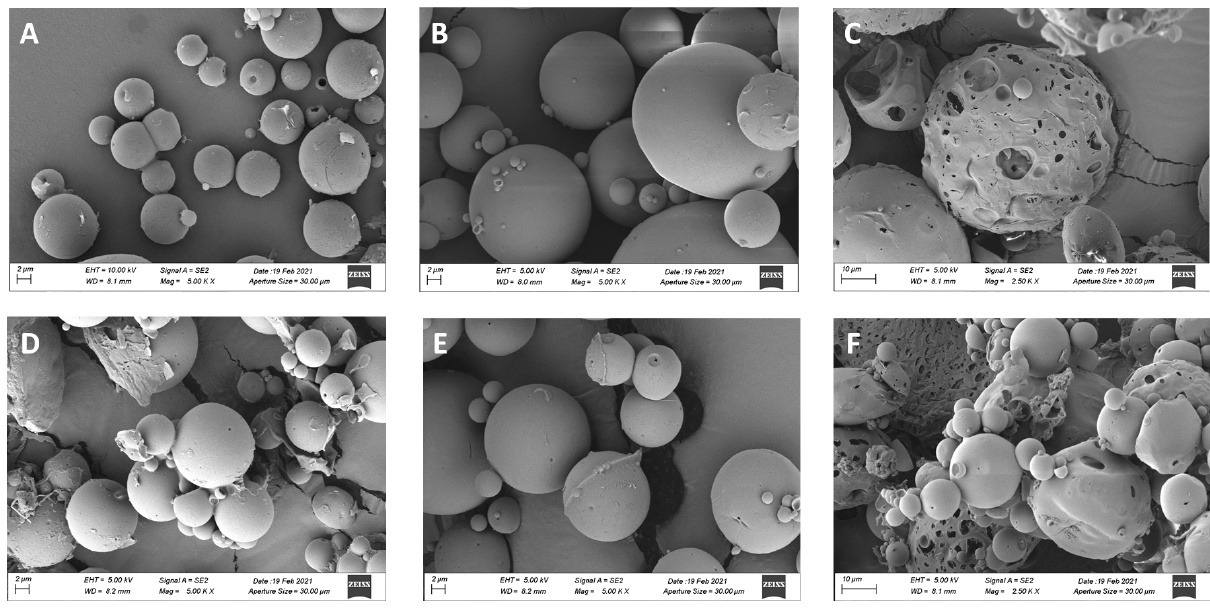
Figure 1. SEM images of ( A ) 20–70 ( B ) 20–90 and ( C ) 20–100 ( D ) 24–70 ( E ) 24–90 and ( F ) 24–100 MPs. The bar is 2 µm in ( A , B , D , E ) and 10 µm in ( C , F ). Table 2. Overall technological features of the produced